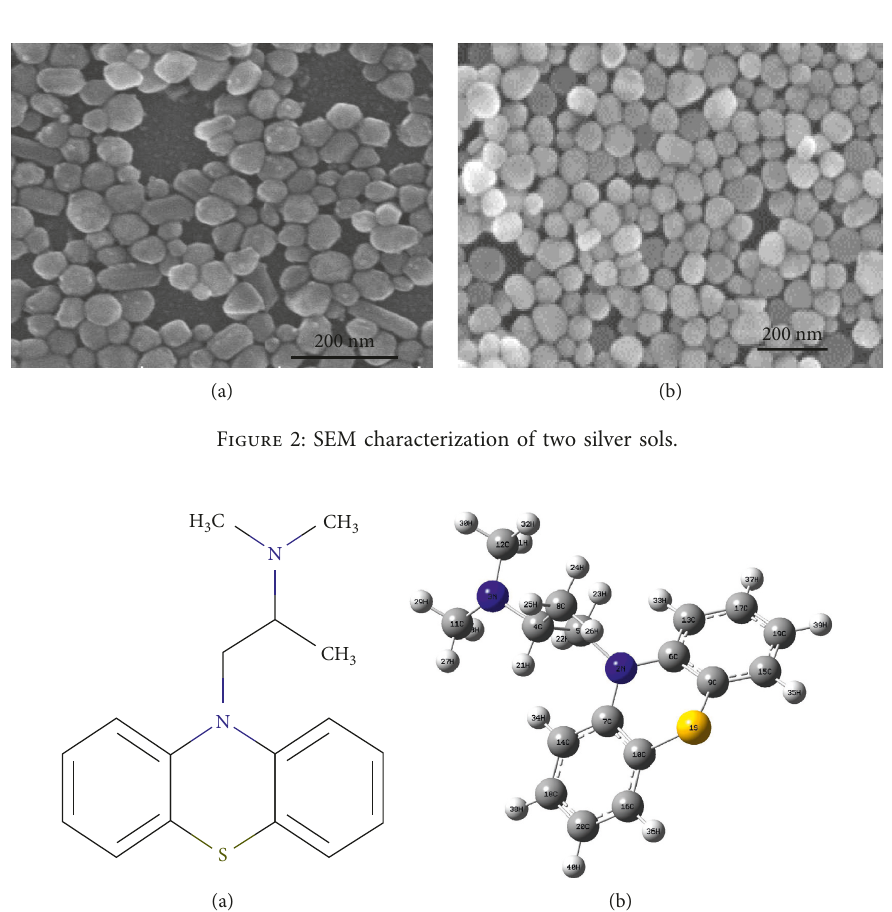
Figure 1: Schematic diagram of main process of experiment. S: scopolamine; P: